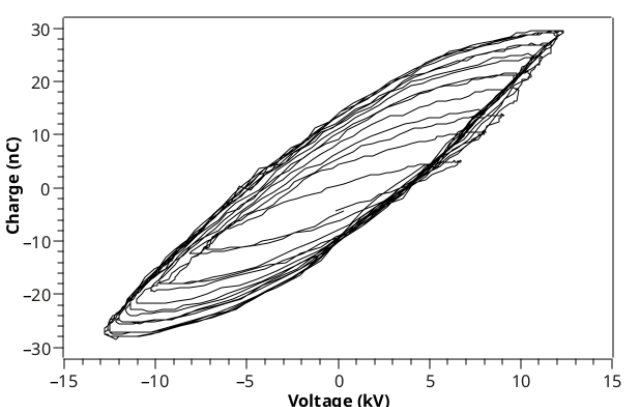
Figure 2. Example of a q − V plot with 15 oscillation cycles.